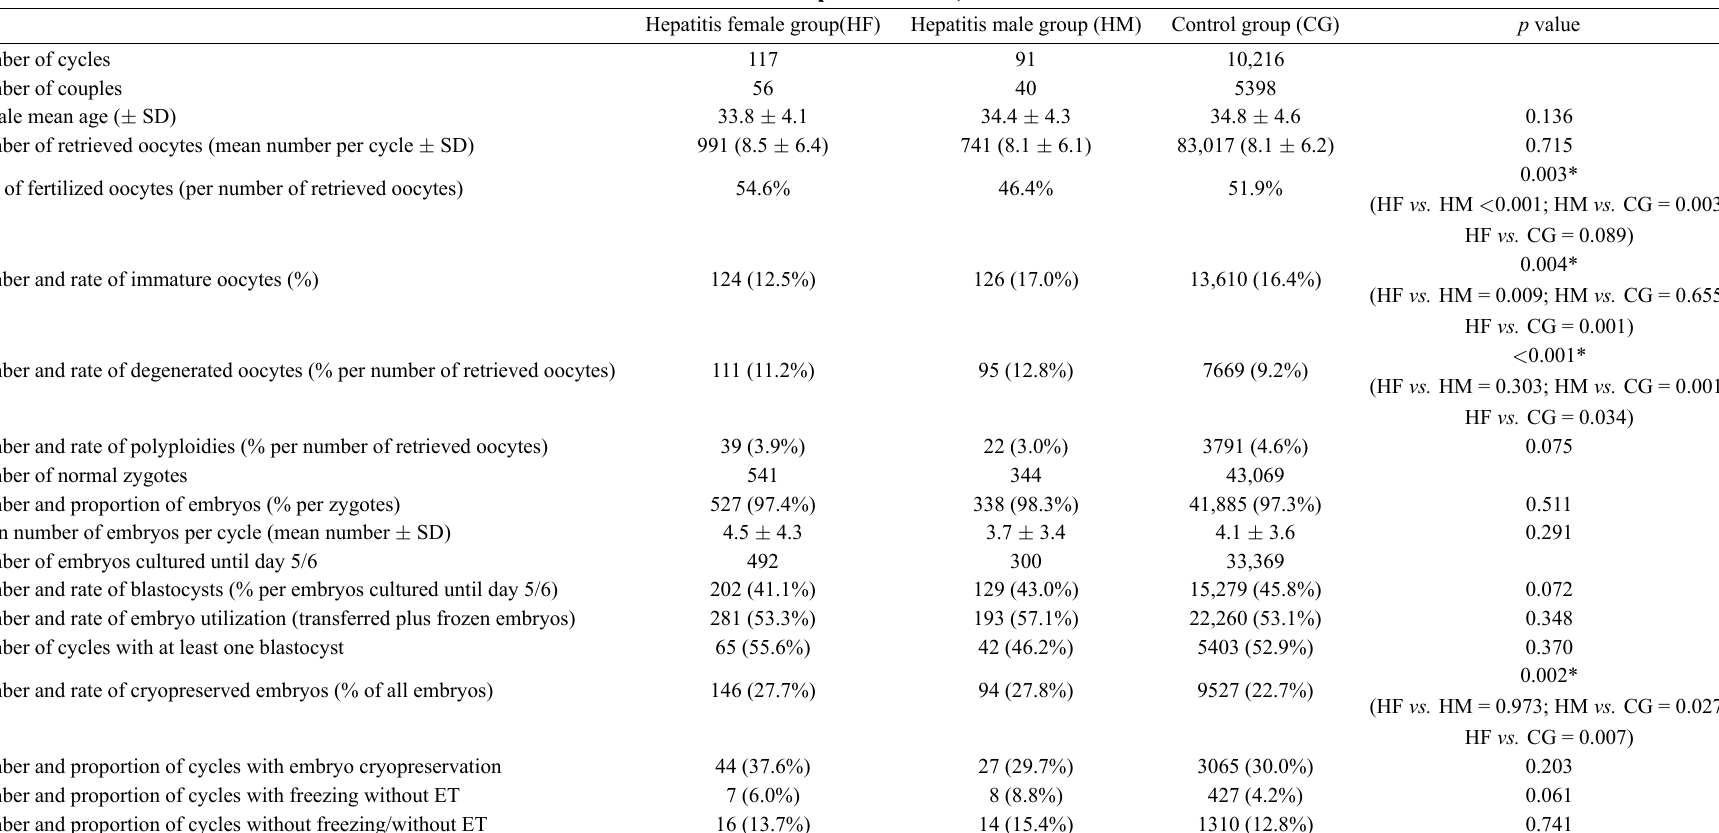
Table 2. The outcome of the in vitro fertilization/intracytoplasmic sperm injection (IVF/ICSI) cycles in terms of oocytes and embryos. Statistically significant differences are marked with an asterisk ( p value <